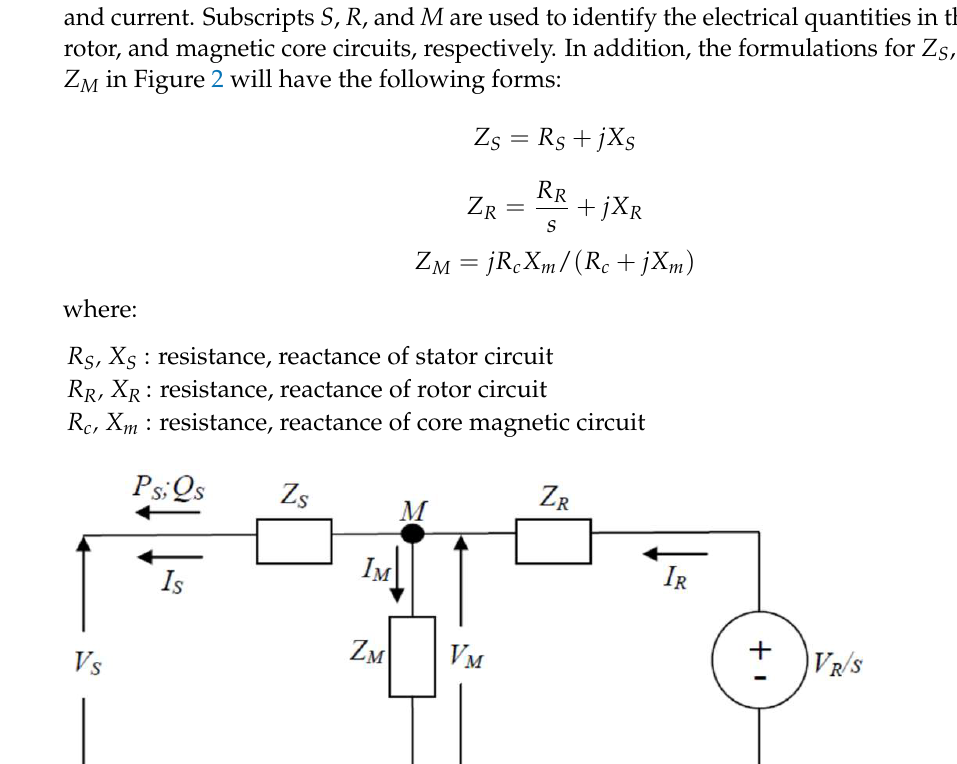
Figure 2. Equivalent circuit of DFIG.